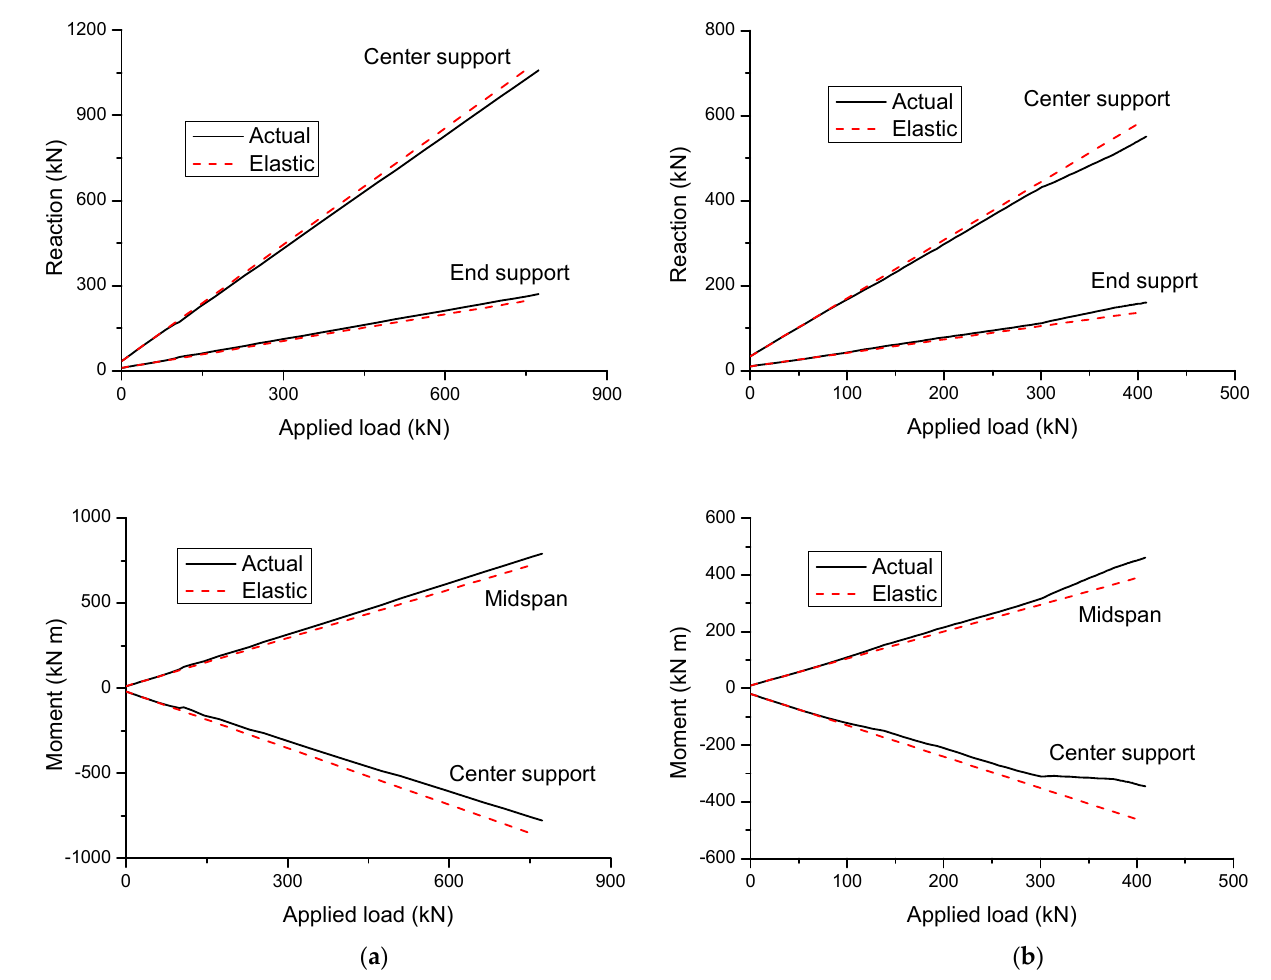
Figure 11. Development of support reactions and bending moments: ( a ) CFRP RC beams and ( b ) steel RC beams.